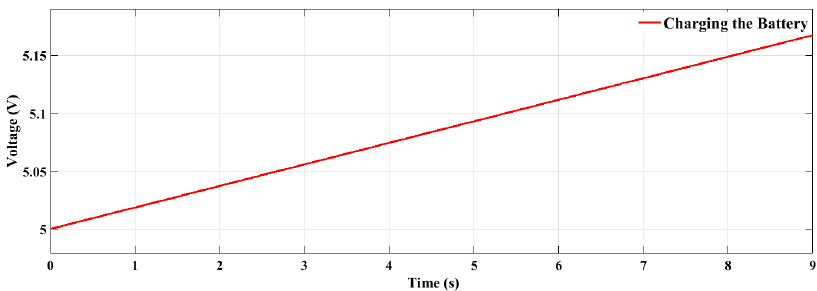
Figure 4. Simulation of electric vehicle battery charging in 10 s.